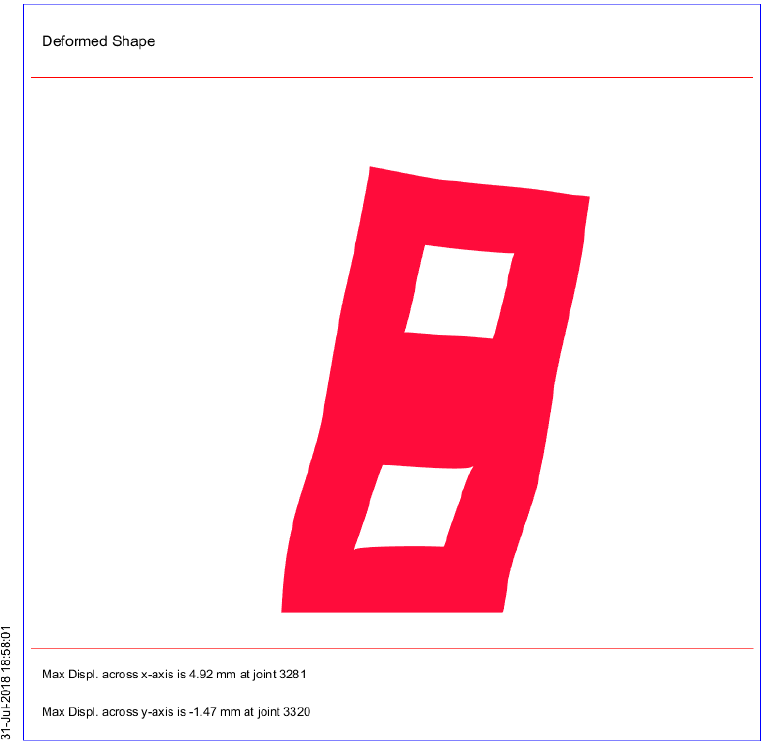
Figure 17. Deformed shape of 2D masonry wall L50H100 (Figure 11a) with two openings (PGA = 0.40 g).